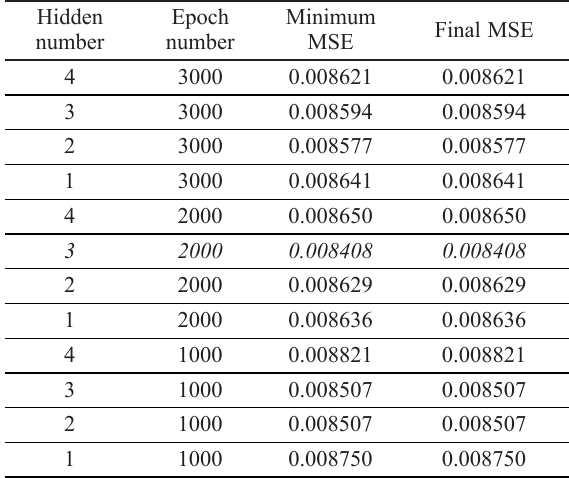
Table 4. Training performance of ANN models